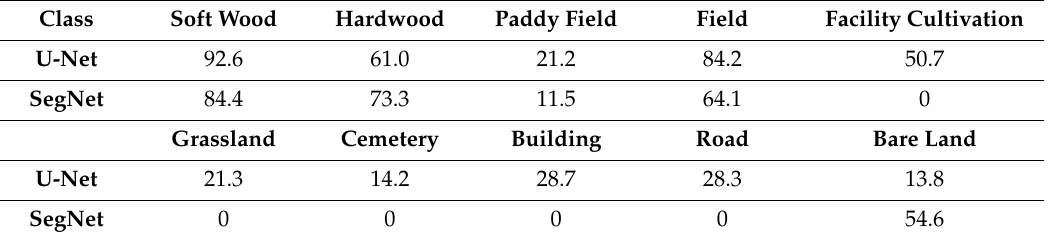
Table 5. Test accuracy for each class (unit